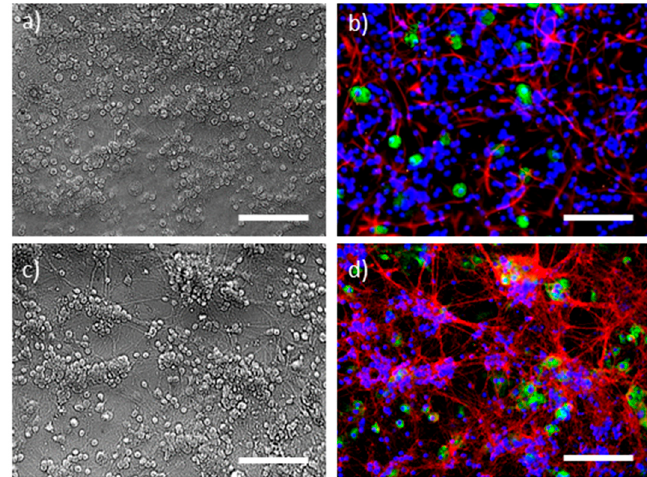
Figure 1. Brightfield ( a , c ) and fluorescent ( b , d ) images of cerebellar neuronal-glial cell cultures. Image ( b ) shows the same cells as in ( a ), and image ( c ) the same cells as in ( d ). In both fluorescent images, all nuclei were stained blue with Hoechst33342, and the microglia are stained green with isolectin GS-IB4. In ( b ), astrocytes (red) are immunolabelled for glial fibrillary acidic protein (GFAP), and in ( d ) the neurons (red) are immunolabelled for synaptosomal-associated protein, 25 kDa (SNAP-25). Scale bars are 100 µm.